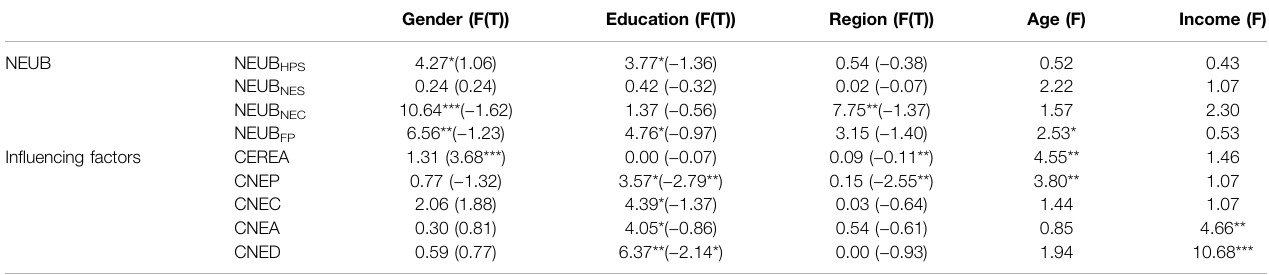
TABLE 3 | Independent sample t -test and ANOVA-check of gender, education, and region on